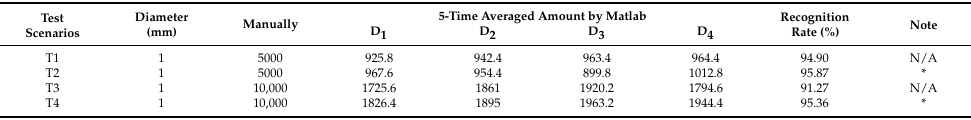
Table 2. Verification of the accuracy of recognition by